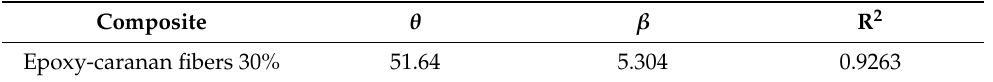
Table 7. Weibull distribution for energy absorbed from the epoxy-caranan composite 30 vol%.